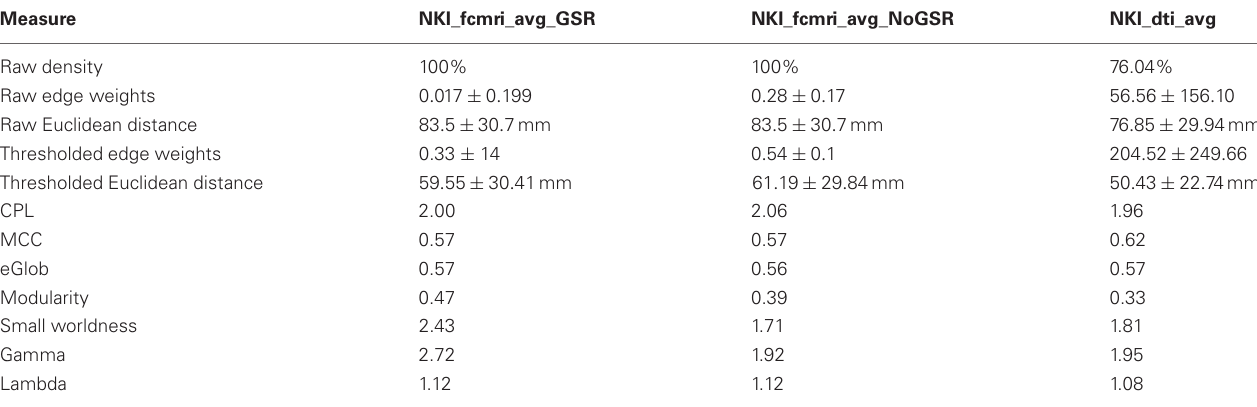
Table 1 | Basic network and global graph theory properties for the fcMRI networks with/without Global Signal Regression and the DTI network.